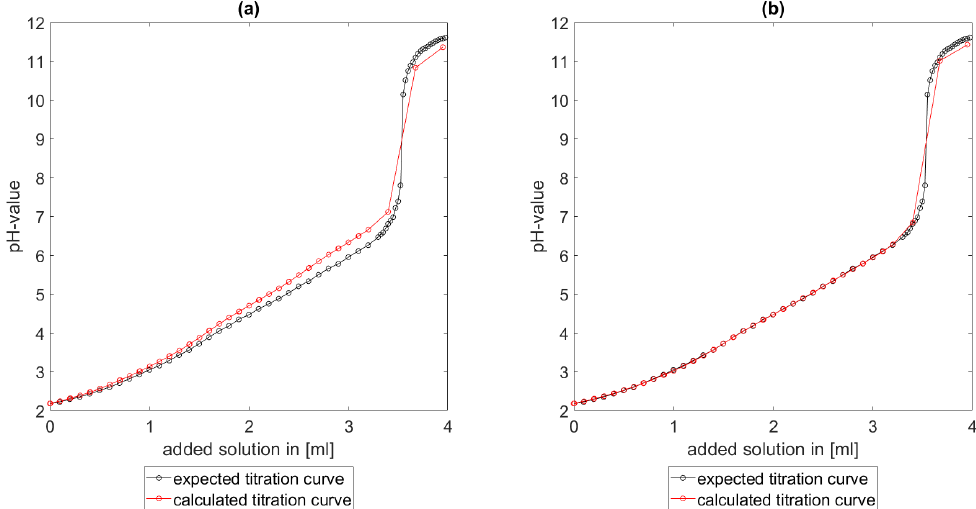
Figure 9. ( a ) Comparison of a measured titration curve and a titration curve calculated from literature data, see Table 6. ( b ) Comparison of optimized titration curve and measured titration curve. The results of optimization are given in Table